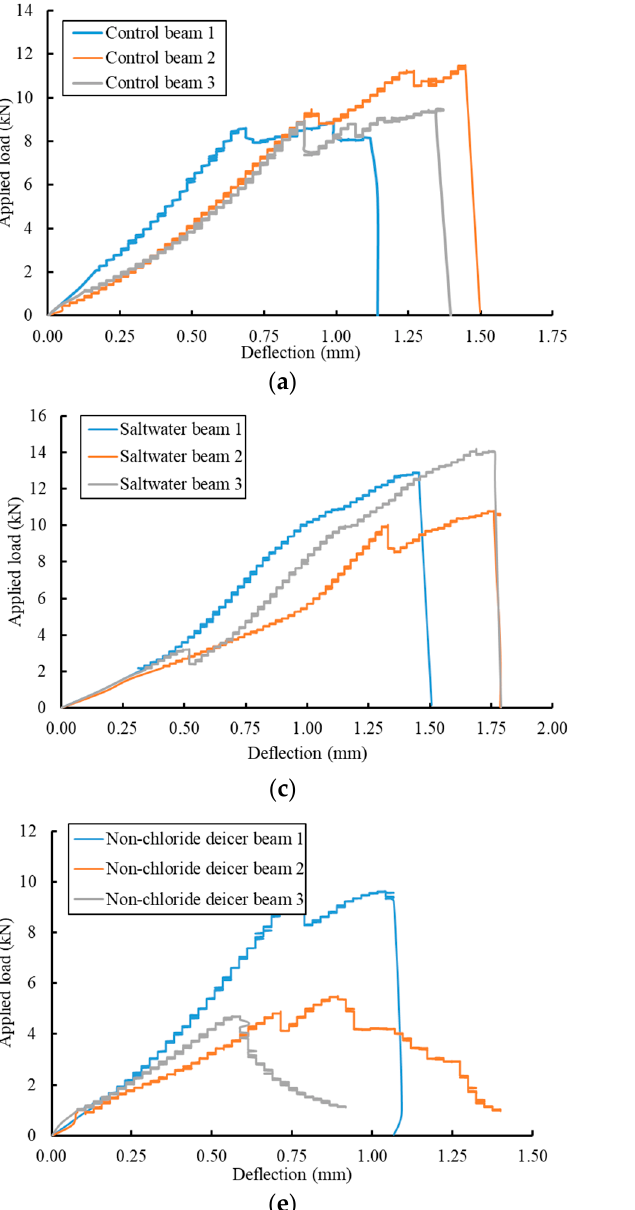
Figure 13. Load deflection response for the effect of different environmental exposures of the three- point bending test results. ( a ) Control specimens. ( b ) Wet-and-dry cycles in tap water. ( c ) Wet-and-dry cycles in saltwater. ( d ) Freeze-and-thaw cycles in chloride deicer. ( e ) Freeze-and-thaw cycles in non-chloride deicer. ( f ) Freeze-and-thaw cycles in tap water. Table 6. Peak loads from the three-point bending tests after 30 cycles of exposure.